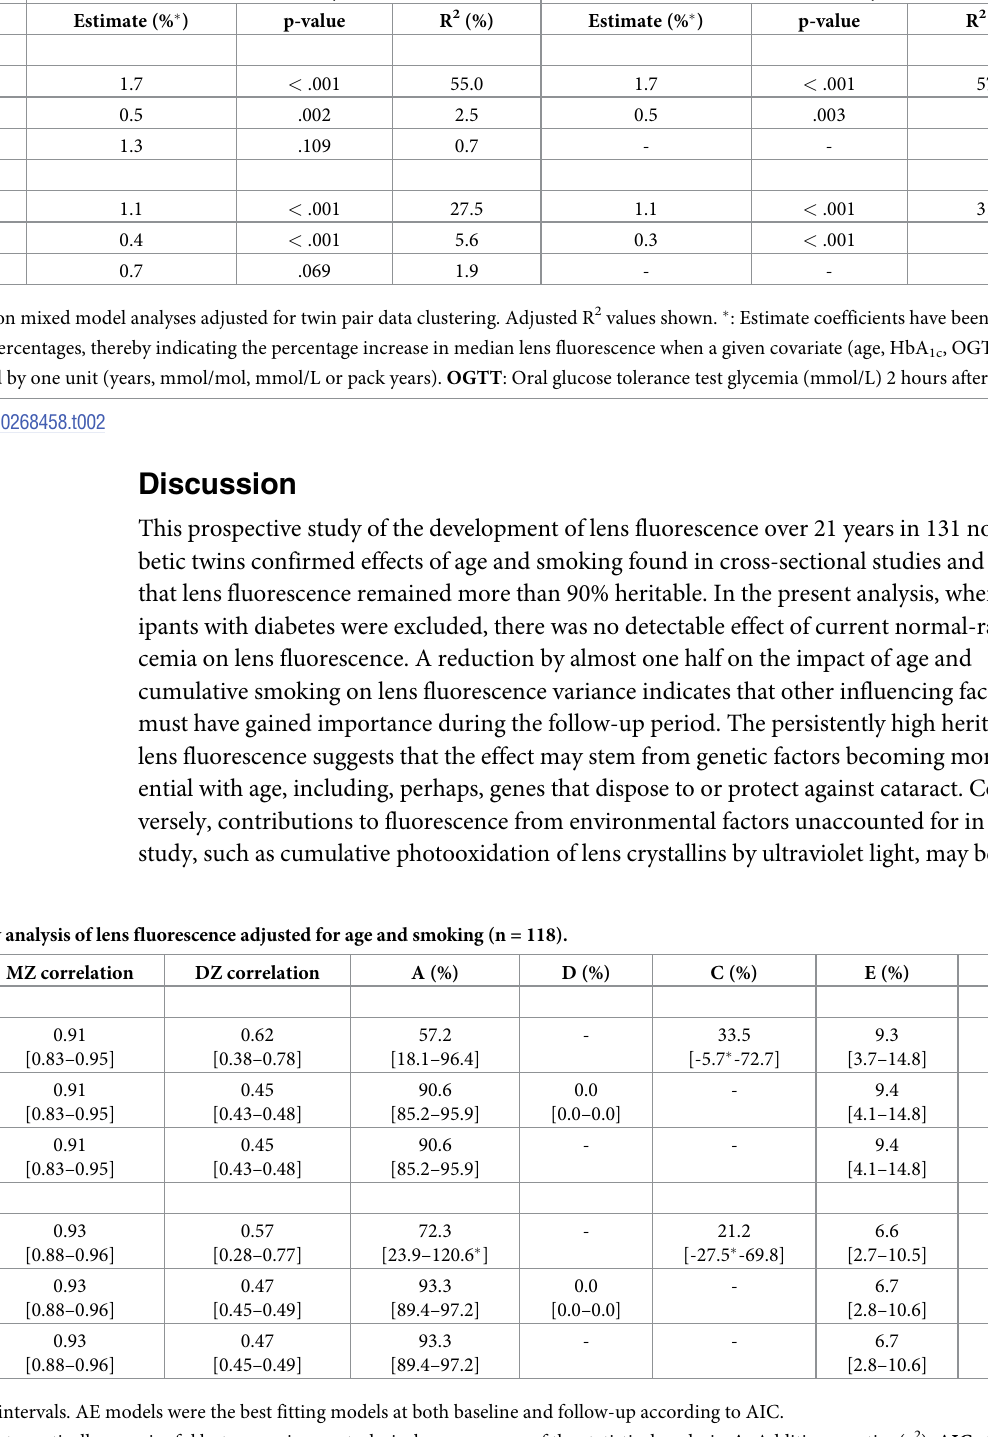
Table 2. Linear regression analyses of lens fluorescence (log10) as a function of covariates (n = 131). Parameter \ analysis type